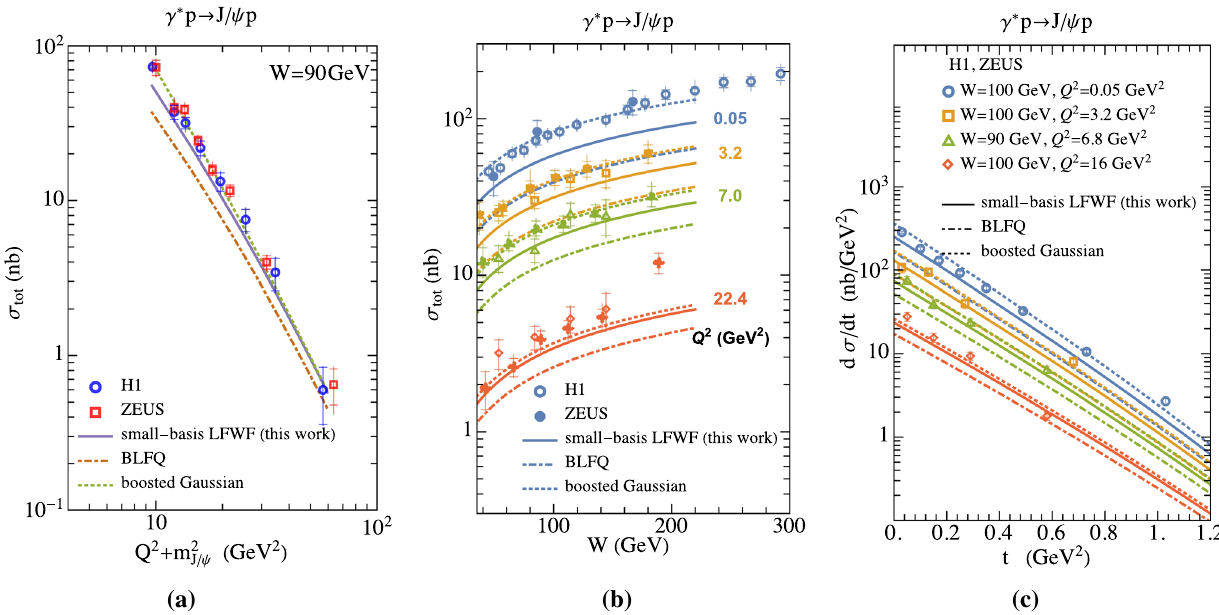
Fig. 14 Predictions of the small-basis LFWF (solid curves), the BLFQ LFWF [26] (dotted curves) and the boosted Gaussian LFWF [5] (dot- dashed curves) compared to the HERA experimental data [84,85]. The inner bars indicate the statistical uncertainties; the outer bars are the sta-